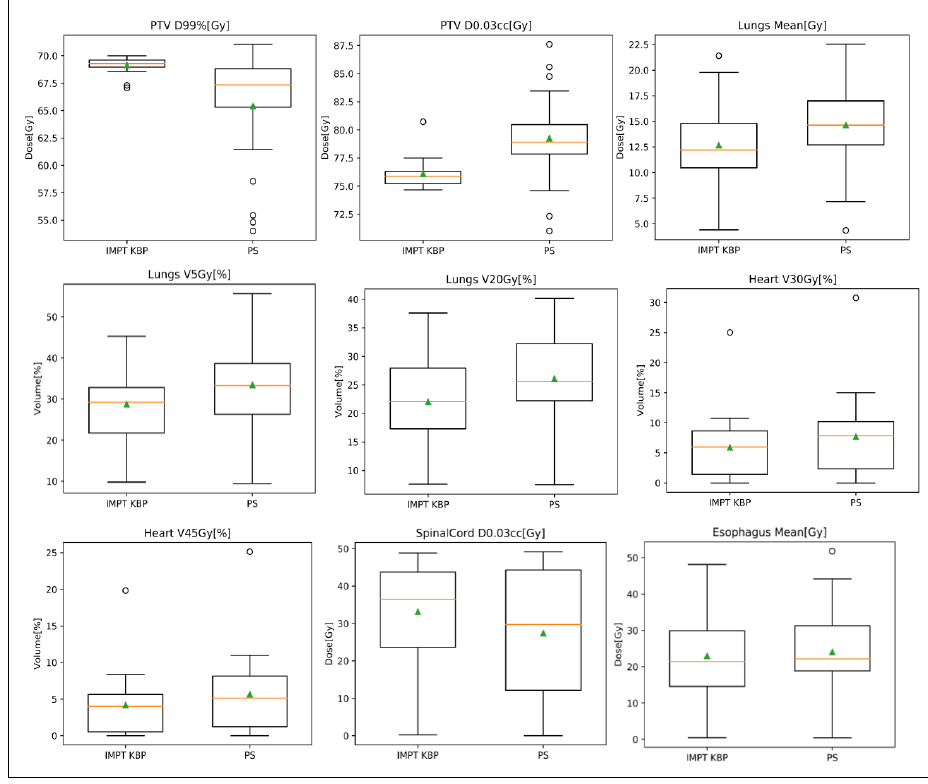
Figure 2. Box plots of dosimetric comparison for IMPT KBP plans versus original proton plans: ( a ) IMPT KBP plans versus original IMPT plans; ( b ) IMPT KBP plans versus original PS plans. (Orange lines indicate the average values and the green triangles indicate the median values; Circles indicate potential outliers).